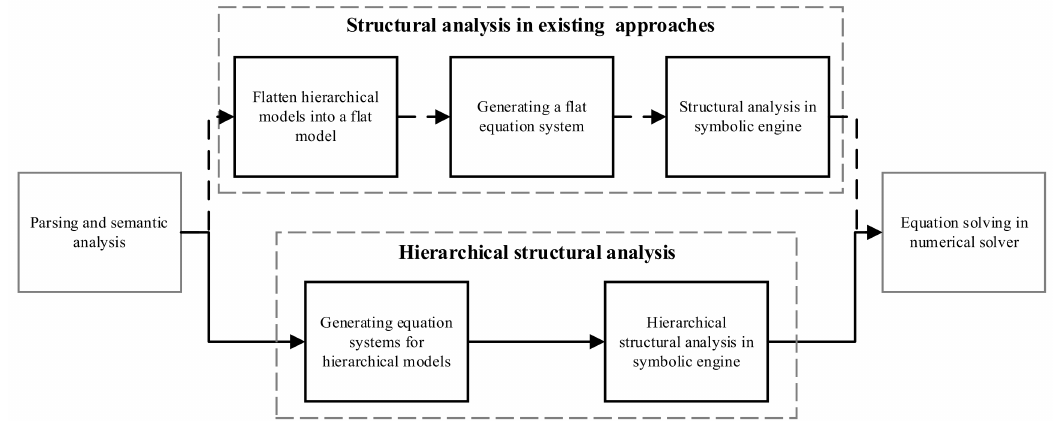
Figure 3. Comparison between the stages of the hierarchical structural analysis method and existing structural analysis